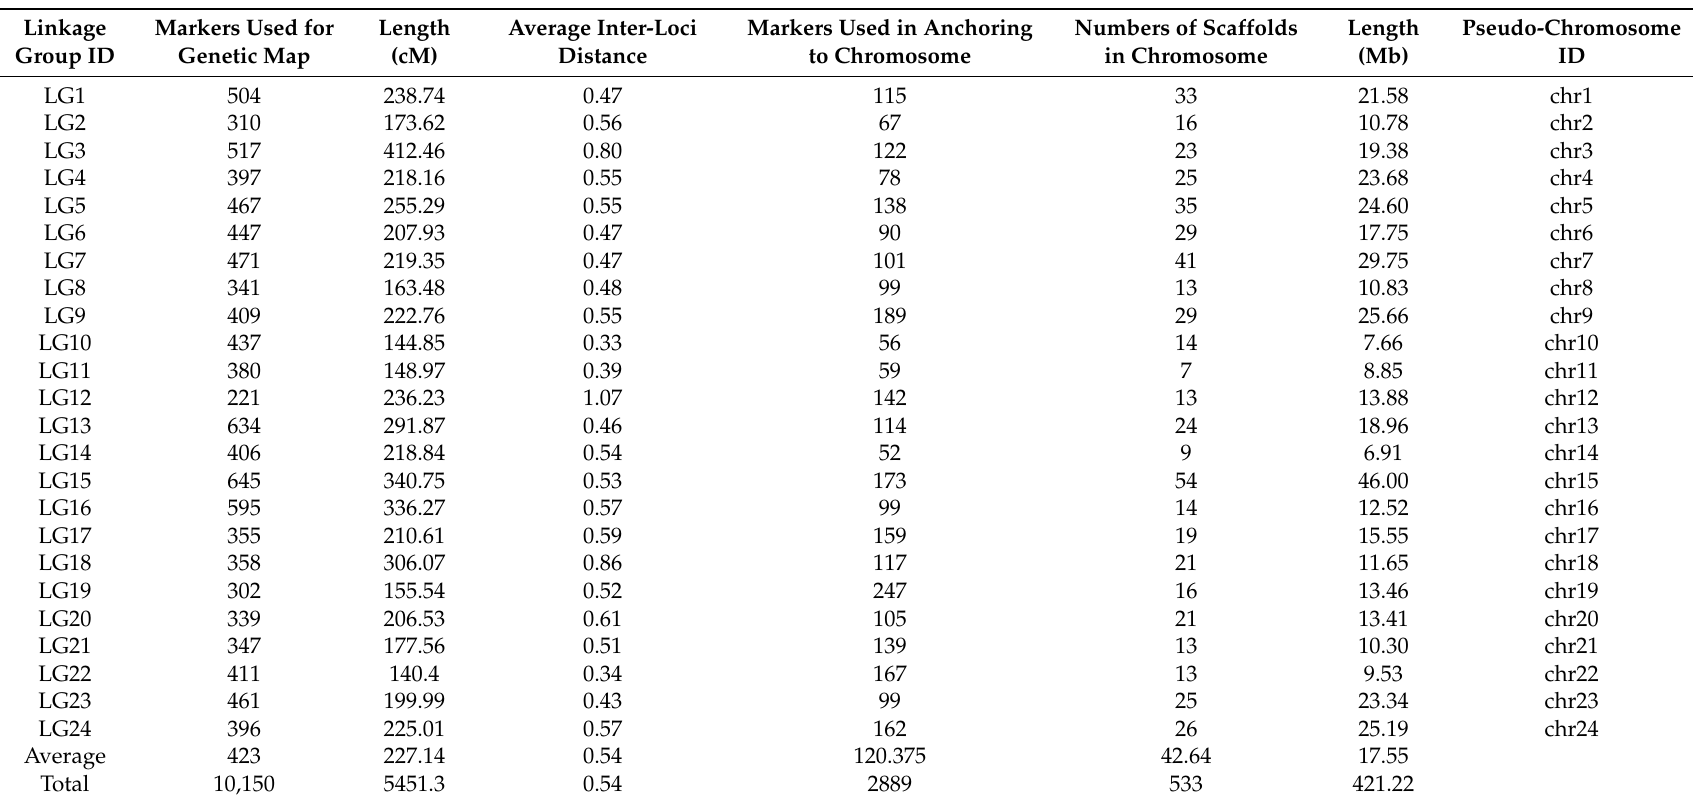
Table 1. Characteristics of genetic maps and pseudo-chromosomes of the large yellow